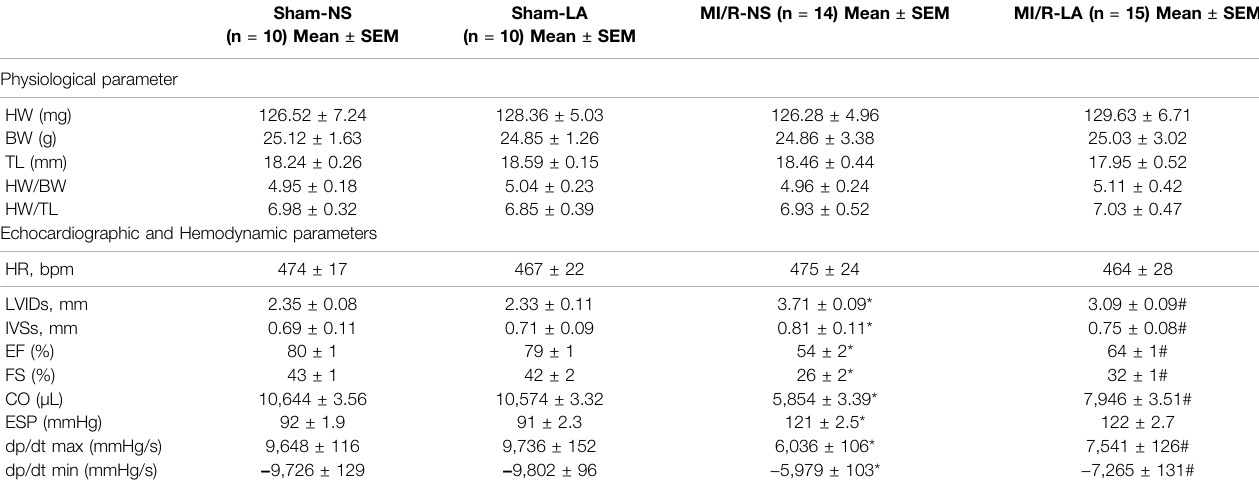
TABLE 1 | Physiological, Echocardiographic and Hemodynamic parameters after